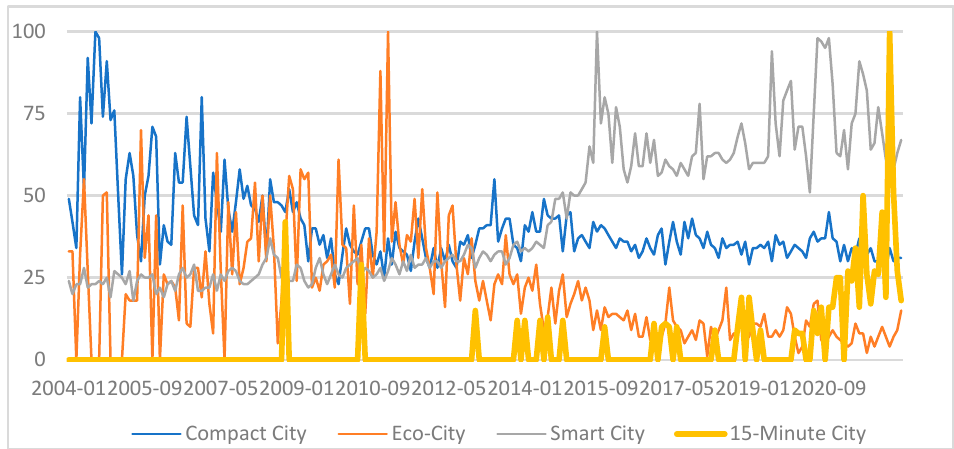
Figure 1. Google Trend Analysis showcasing the popularity of the 15 ‐ Minute City against the Compact City, Eco ‐ City, and Smart City models. Sourced from Google Trends and analysed by the authors [45].